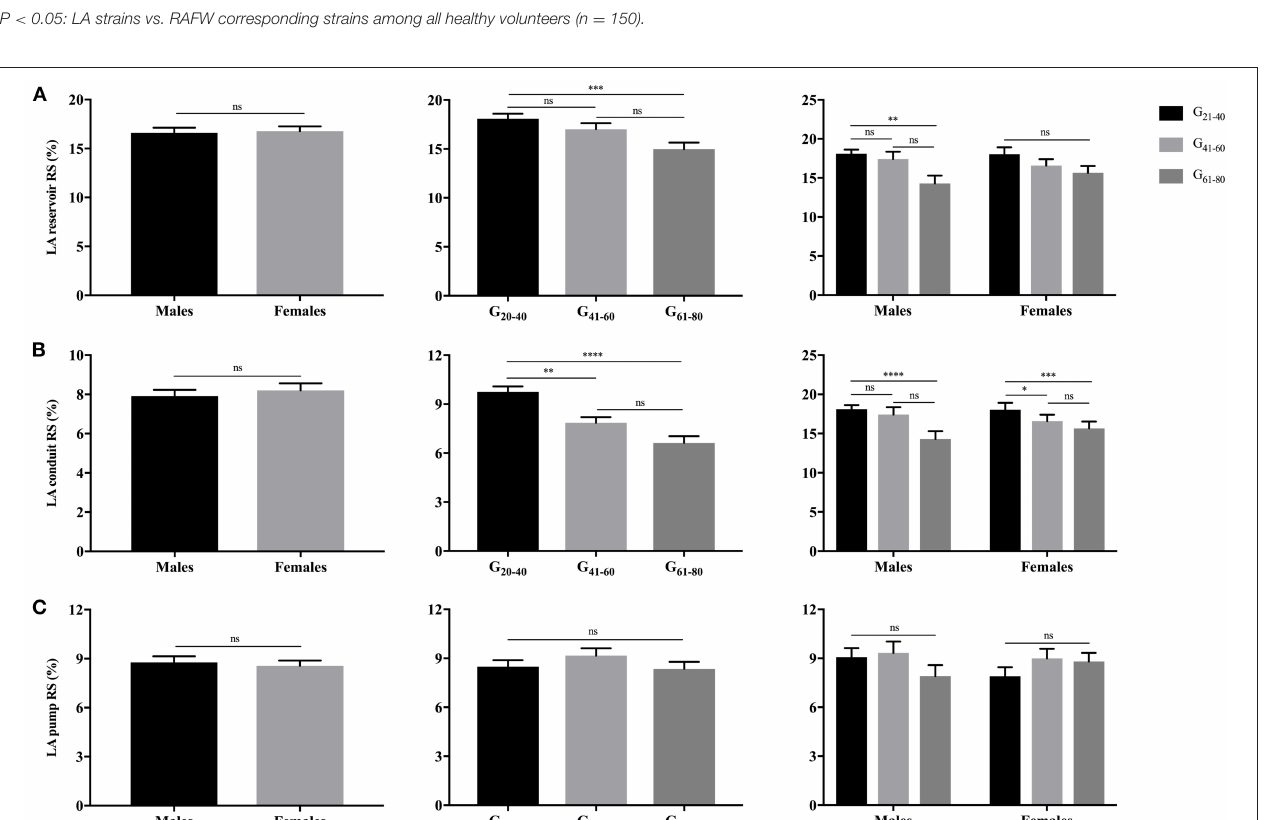
correlated with EF t ( r = 0.19–0.49, P < 0.05), EF p ( r = 0.19– 0.45, P < 0.05) and EF a ( r = 0.19–0.38, P < 0.05). RAFW pump strains were positively correlated with RVEF ( r = 0.33, P <